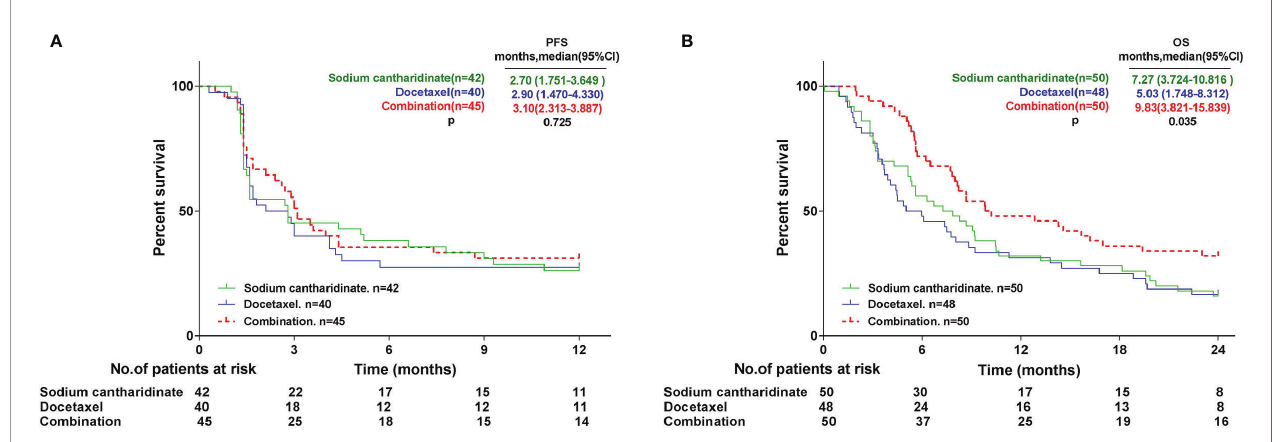
FIGURE 2 | Kaplan-Meier curves for (A) progression-free survival (PFS) and (B) overall survival